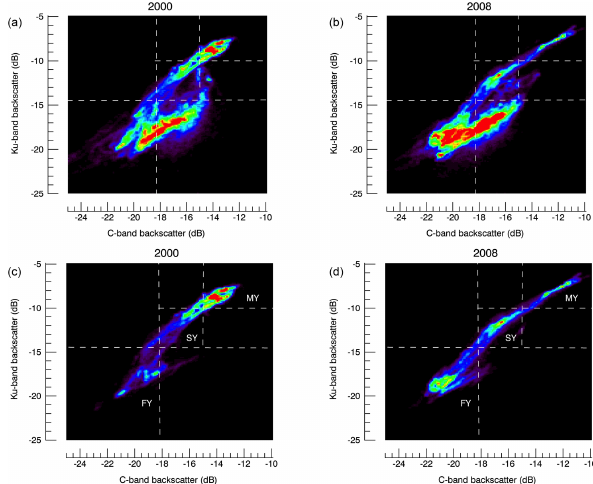
Figure 9. Joint distributions of wintertime (March) sea ice backscat- ter at C-band ( x axis) and Ku-band ( y axis) before (a, b) and af- ter (c, d) , applying the geographical mask in 2000 ( a, c , ERS vs. QuikSCAT) and 2008 ( b, d , ASCAT vs.